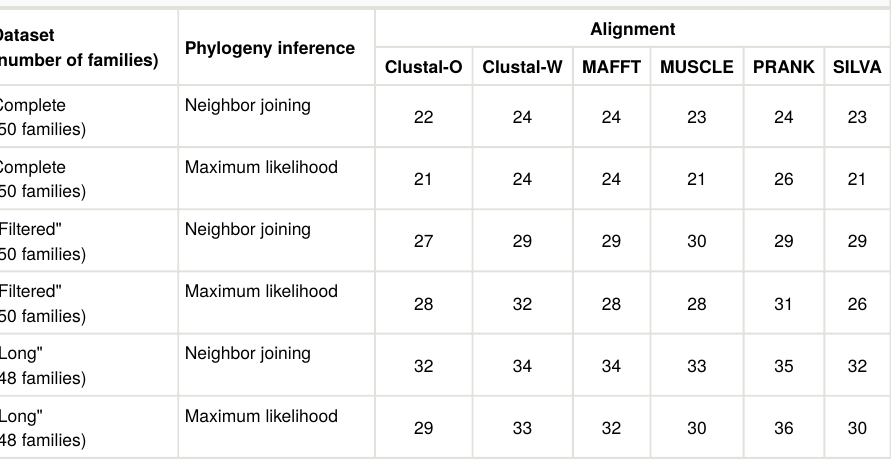
Number of nematode families resolved as monophyletic and with high ( ≥ 70%) bootstrap support for all combinations of sequence dataset, alignment and phylogeny